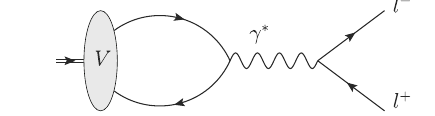
Fig. 2 The dilepton decay process of a vector meson V (such as J /ψ , ϒ